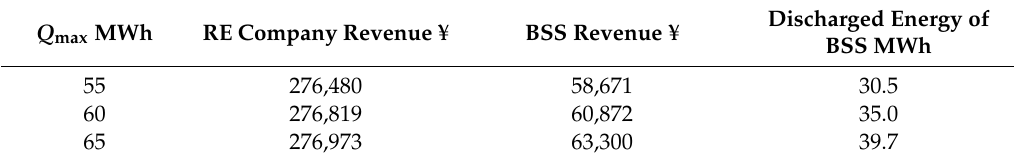
Table 5. The influence of Q max on the RE company and BSS.